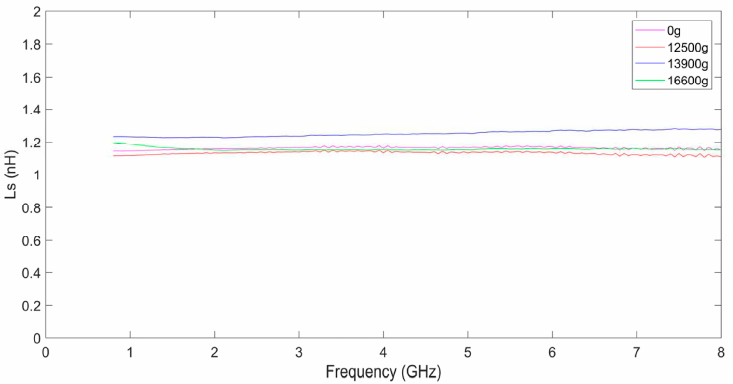
Figure 13. The series inductance of the inductor coils.